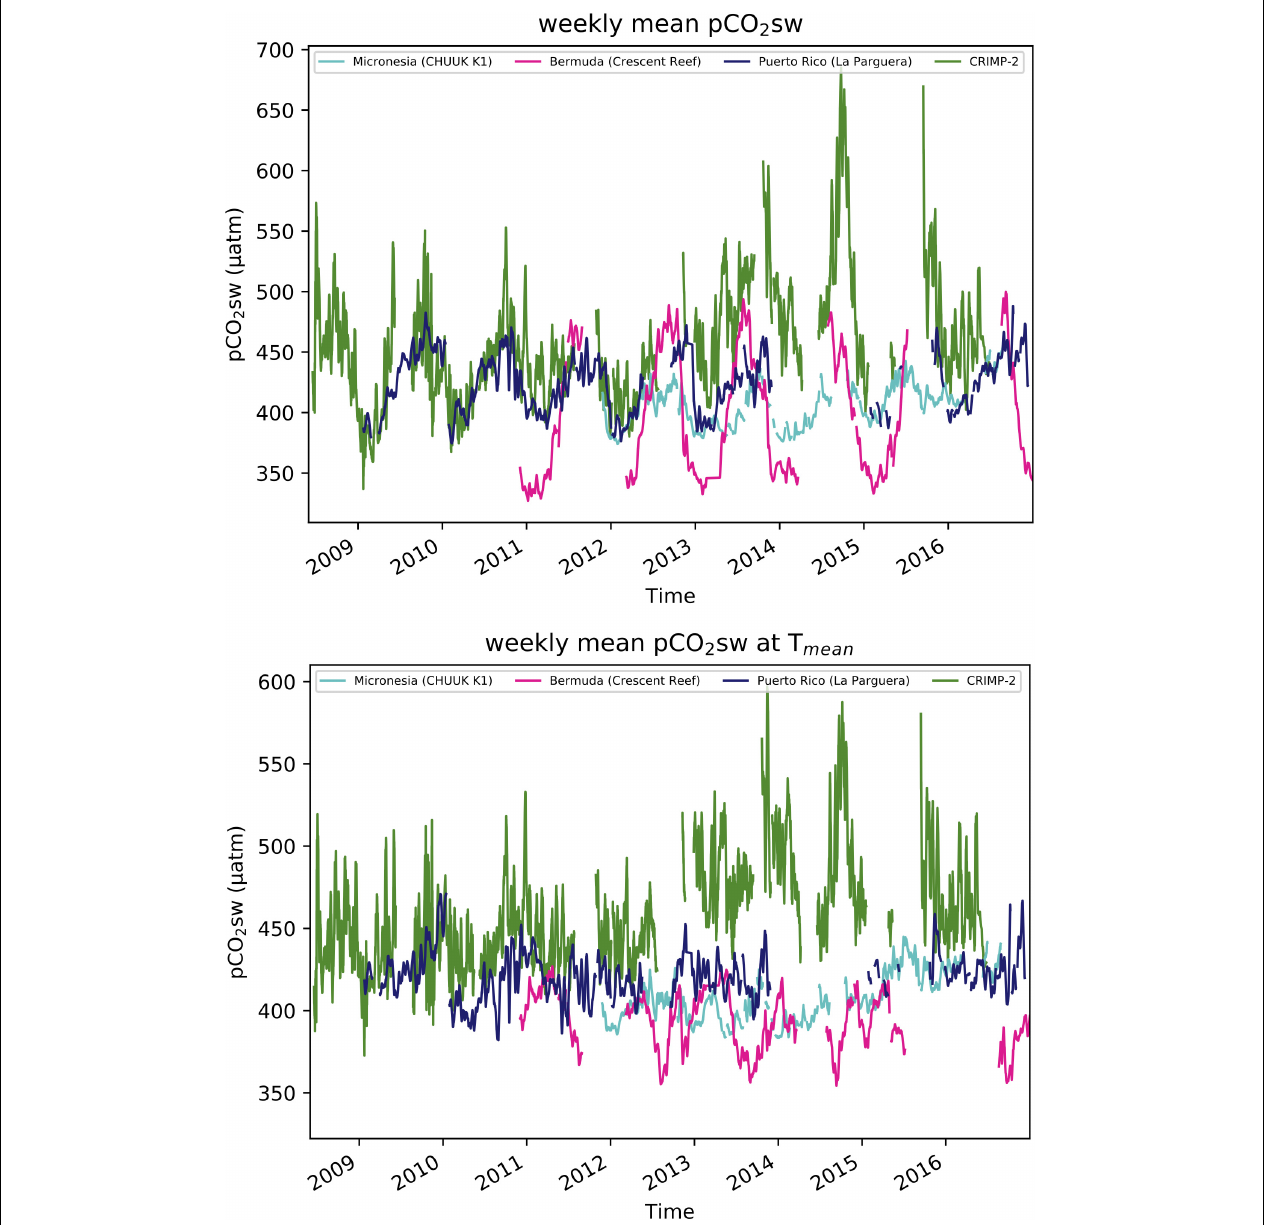
FIGURE 9 | Time-series of weekly mean p CO 2 sw (Top) and temperature normalized p CO 2 sw ( p CO 2 sw at T mean , Bottom ) at different reef sites for June 2008 through December 2016.